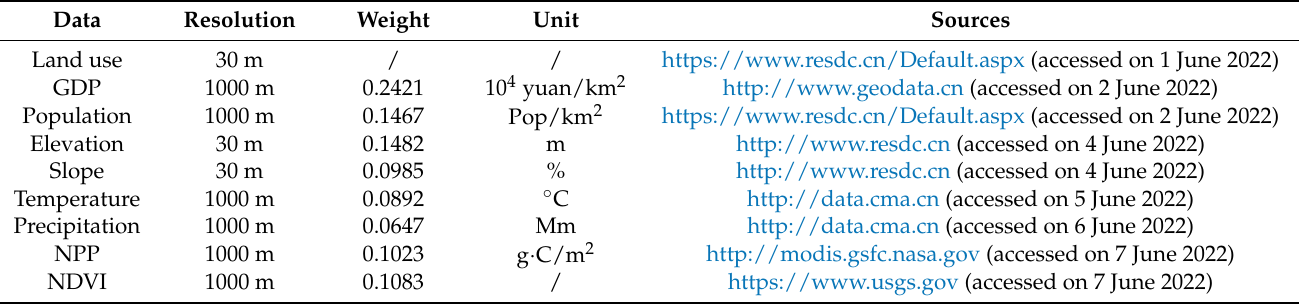
Table 1. Data used for the study and sources.